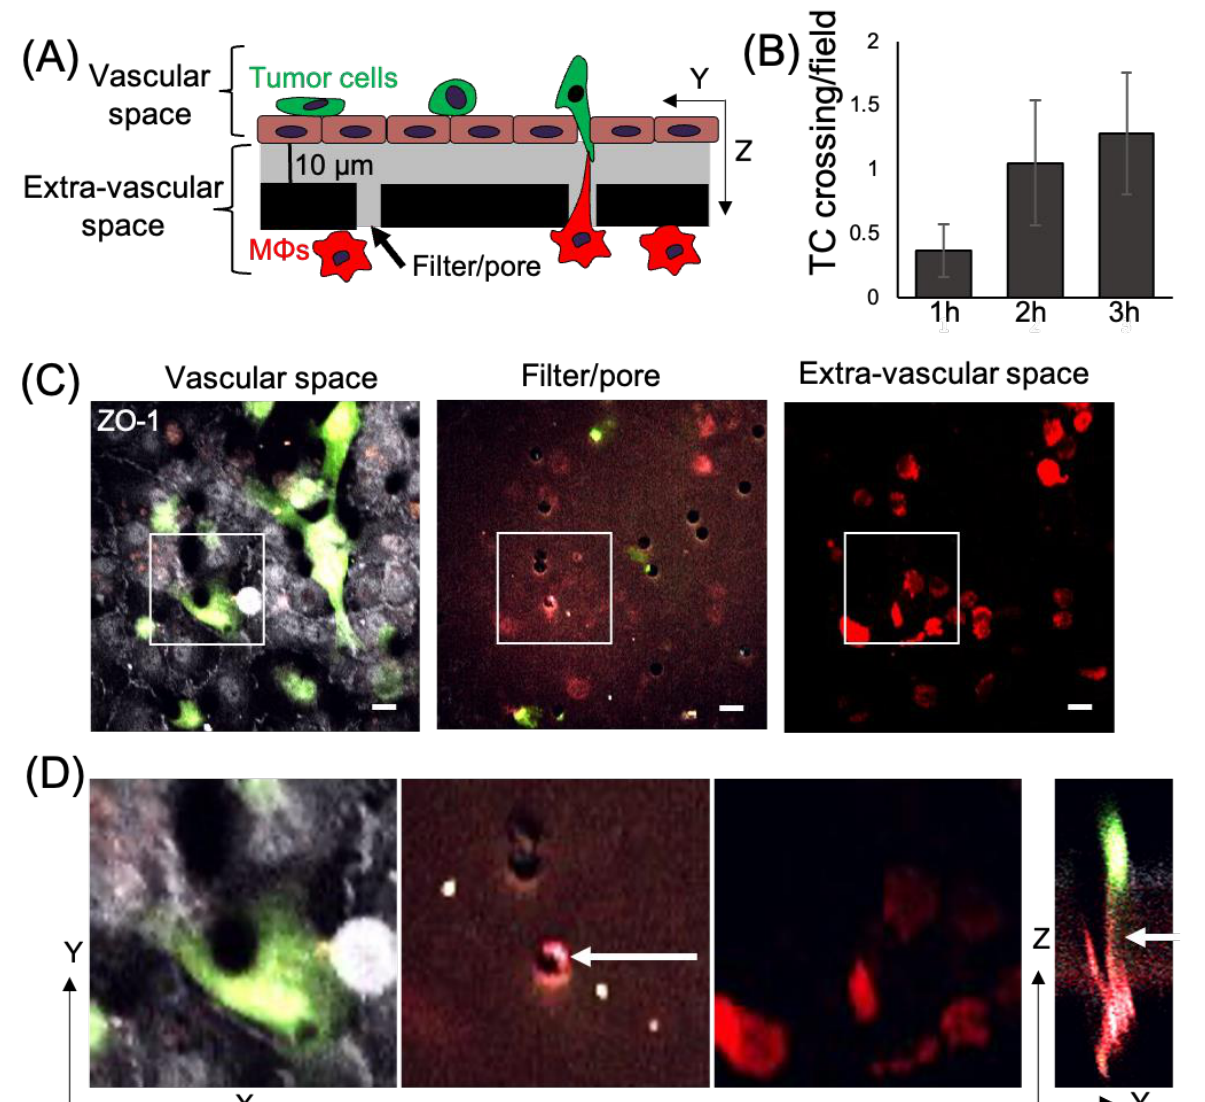
Figure 1. Macrophage TMCs connecting to tumor cells can be detected using an in vitro tumor cell extravasation transendothelial migration (eTEM) assay. ( A ) Schematic representation of the eTEM assay. The vascular space is contained in the upper part of the chamber and contains green labeled tumor cells on top of a confluent endothelial layer. The endothelial layer is supported by a matrigel (grey) coated filter with 8 µ m pores with red labeled macrophages (M Φ s) on the underside of the filter (the extra-vascular space). ( B ) The number of tumor cells (TC) crossing the endothelium over time was determined as the number per field in the extravascular space. ( C ) Representative images of the vascular space, the supportive filter, and the extravascular space. Tumor cells and